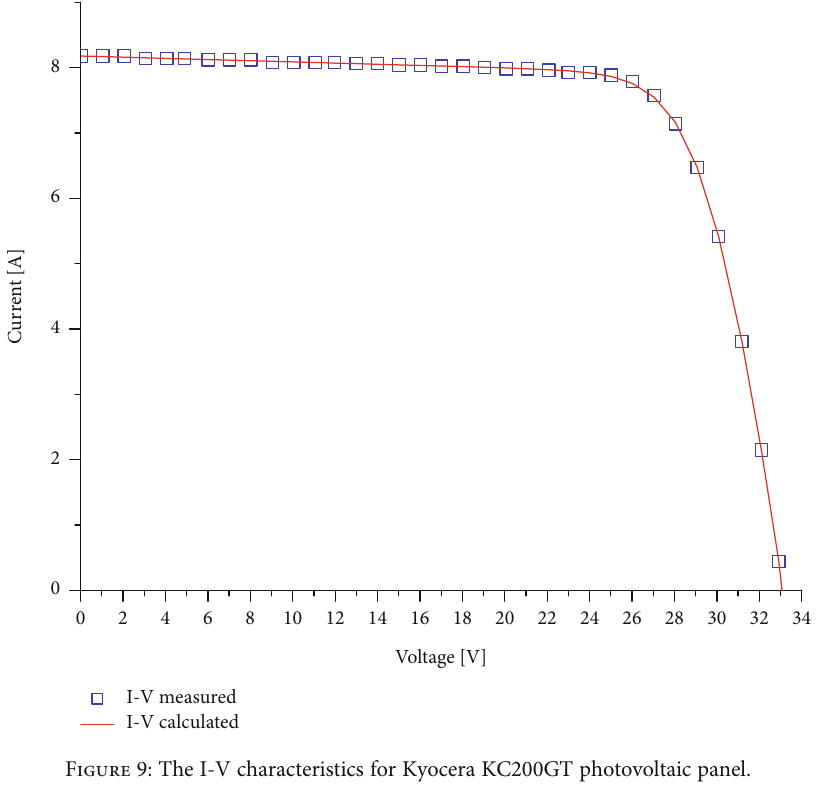
Figure 9: The I-V characteristics for Kyocera KC200GT photovoltaic panel.